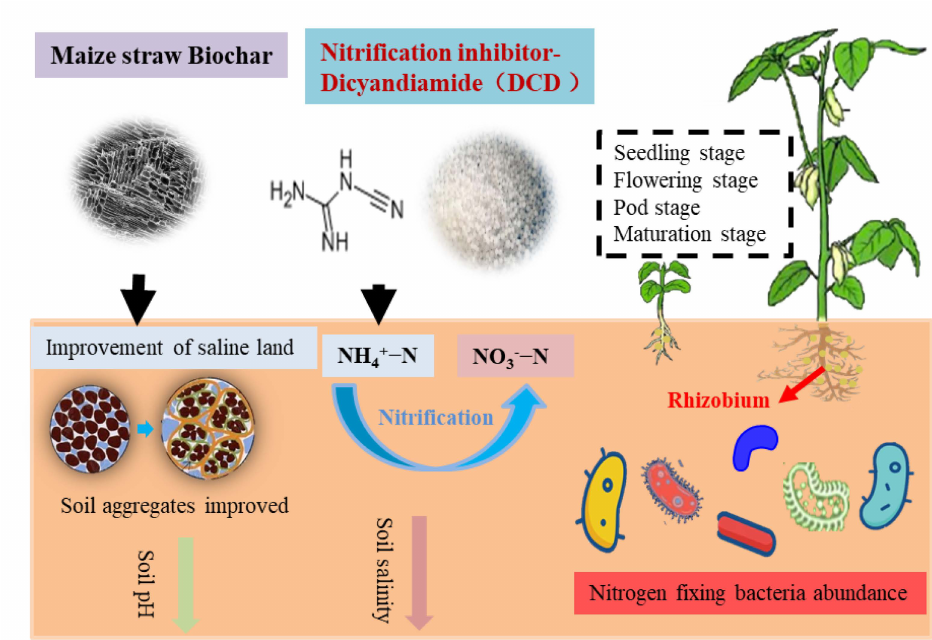
Figure 1. The conceptual model diagram of the effect of biochar and DCD on the